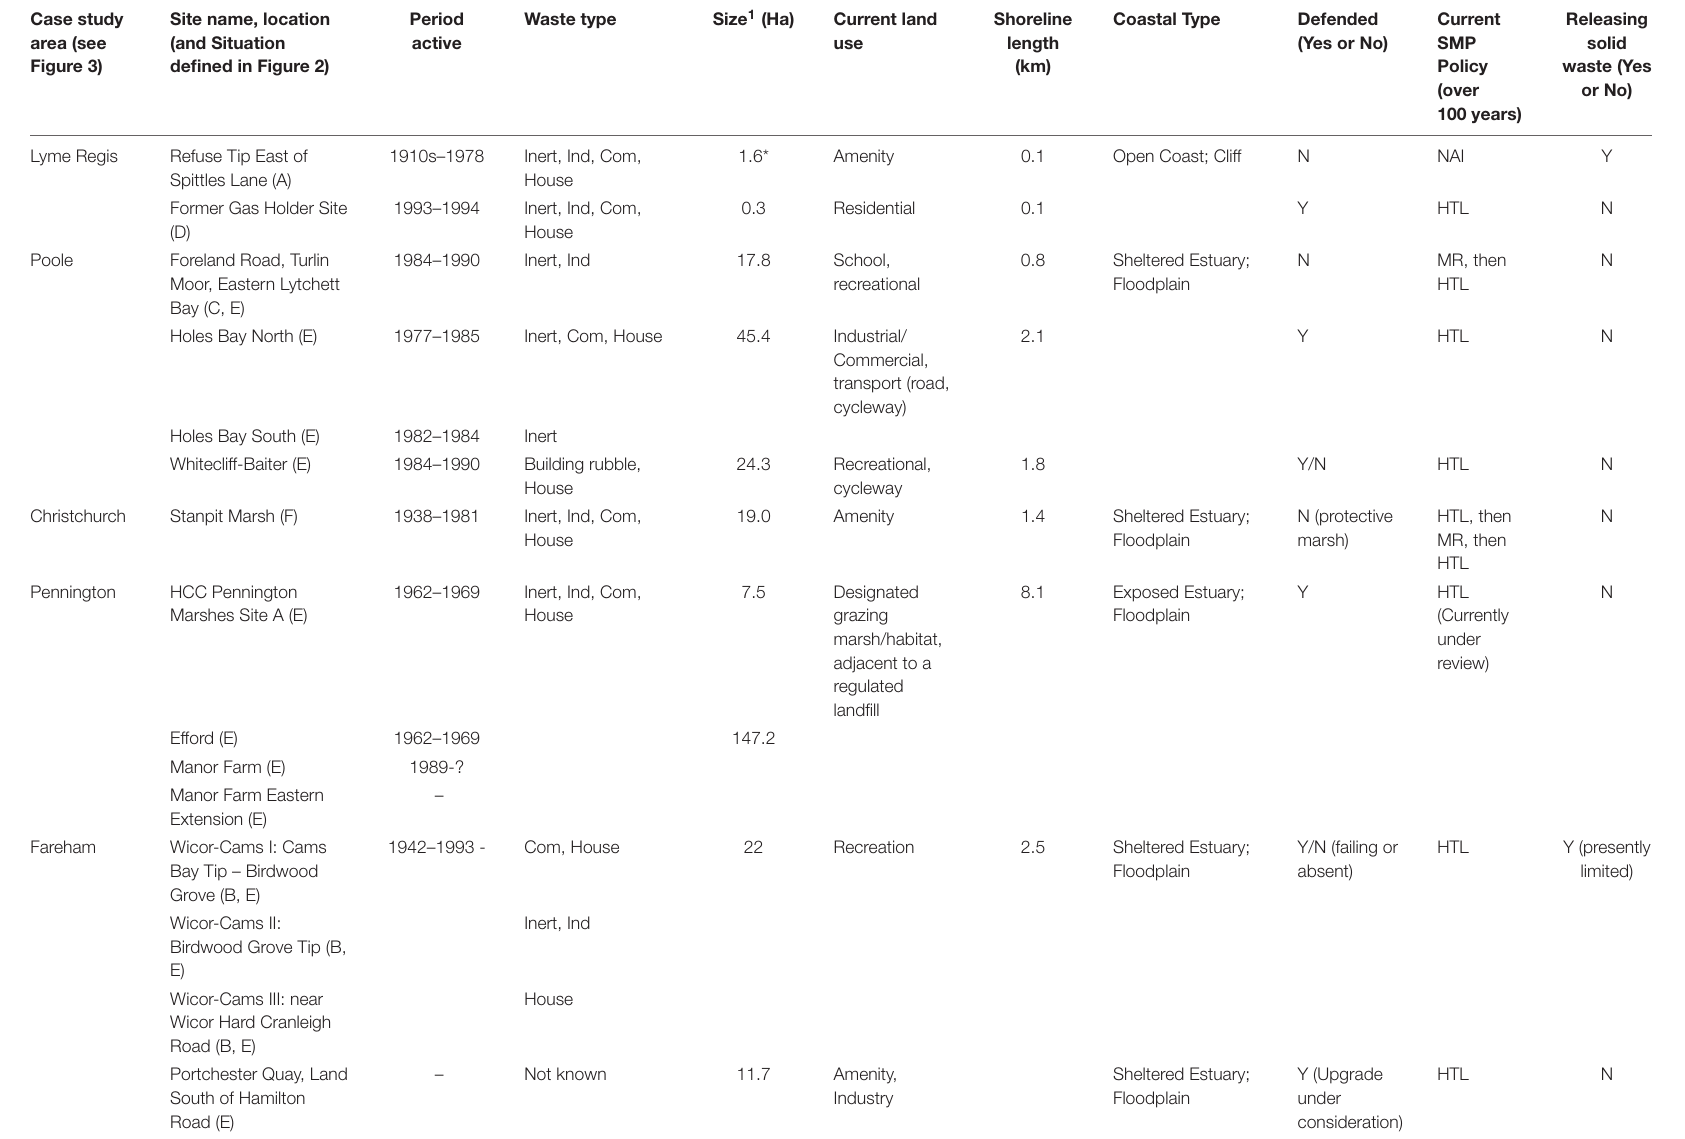
TABLE 1 | Selected case studies of coastal landfill sites on the central south coast of England [adapted from Wadey et al. (2019) with additional information for Spittles Lane, Pennington and Wicor Cams from Nicholls et al. (2018b) and Beaven et al. (2020)]. Case study Site name, location area (see (and Situation Figure 3) defined in Figure